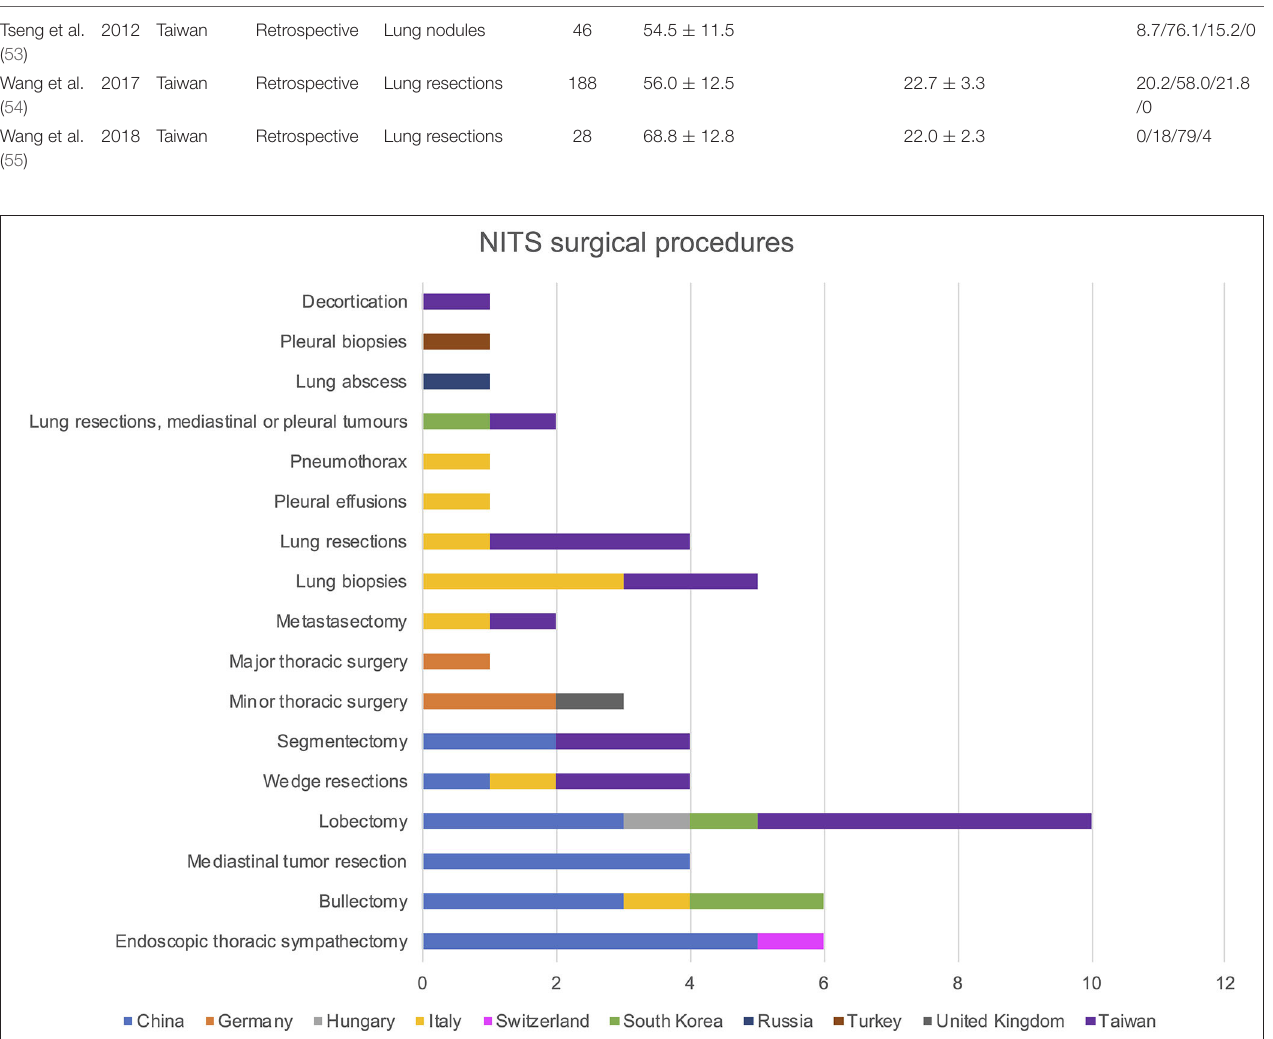
FIGURE 2 | Frequency distribution of NITS surgical procedures by country of